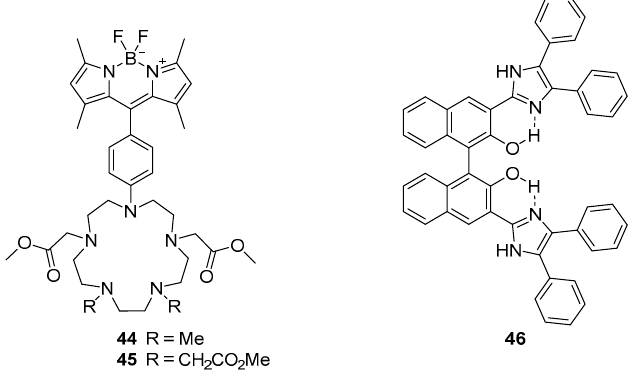
Figure 19. The unusual penta-azamacrocyclic receptor in 44 and 45 is selective for Mn 2+ , binding of which is reported by the appended BODIPY fluorophore via a mechanism thought to involve suppression of PET [120]. BINOL derivative 46 on the other hand is a ratiometric probe for Zn 2+ , binding of which can be monitored by following changes in fluorescence emission at 427 and 549 nm [121].